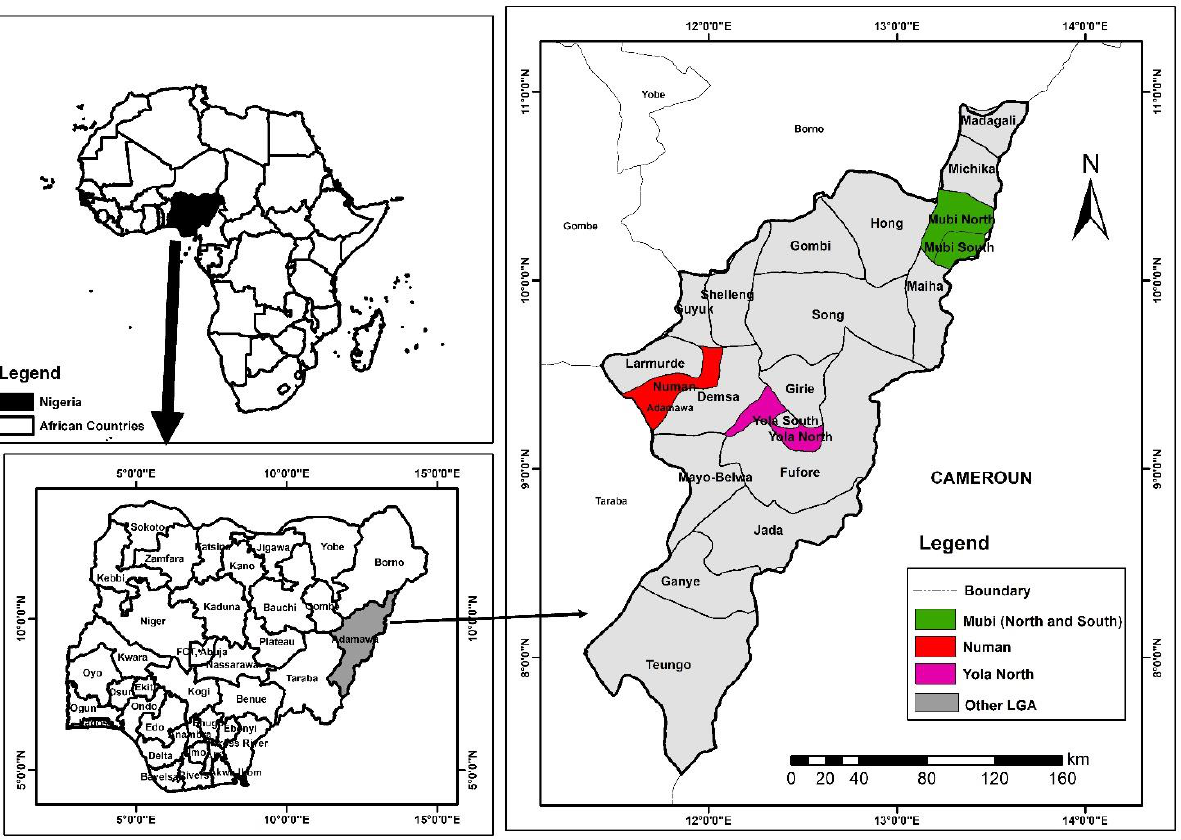
Figure 1. A map of Adamawa State showing the study areas.